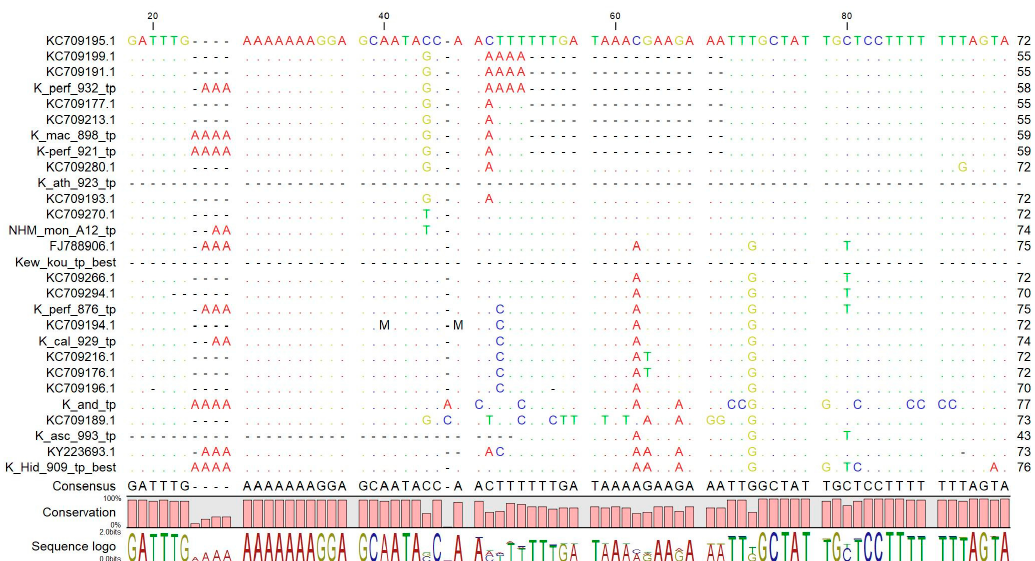
Figure 5. Alignment of database and reference sample psbA 3 ′ UTR RNA stem-loop region. Database sequences are labelled with GenBank accession numbers. Reference samples are labelled according to source (K = Kew; NHM = Natural History Museum), abbreviated species name (“perf” = H. perforatum etc.) and abbreviated voucher number as shown in Table S1.